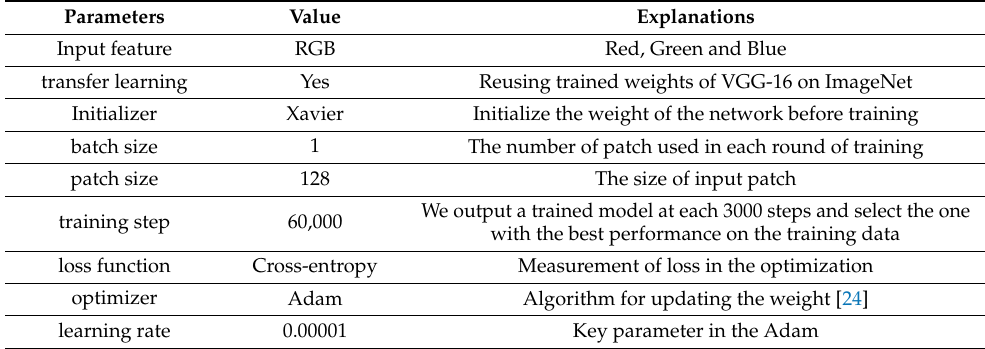
Table 6. Key parameters in the FCN model